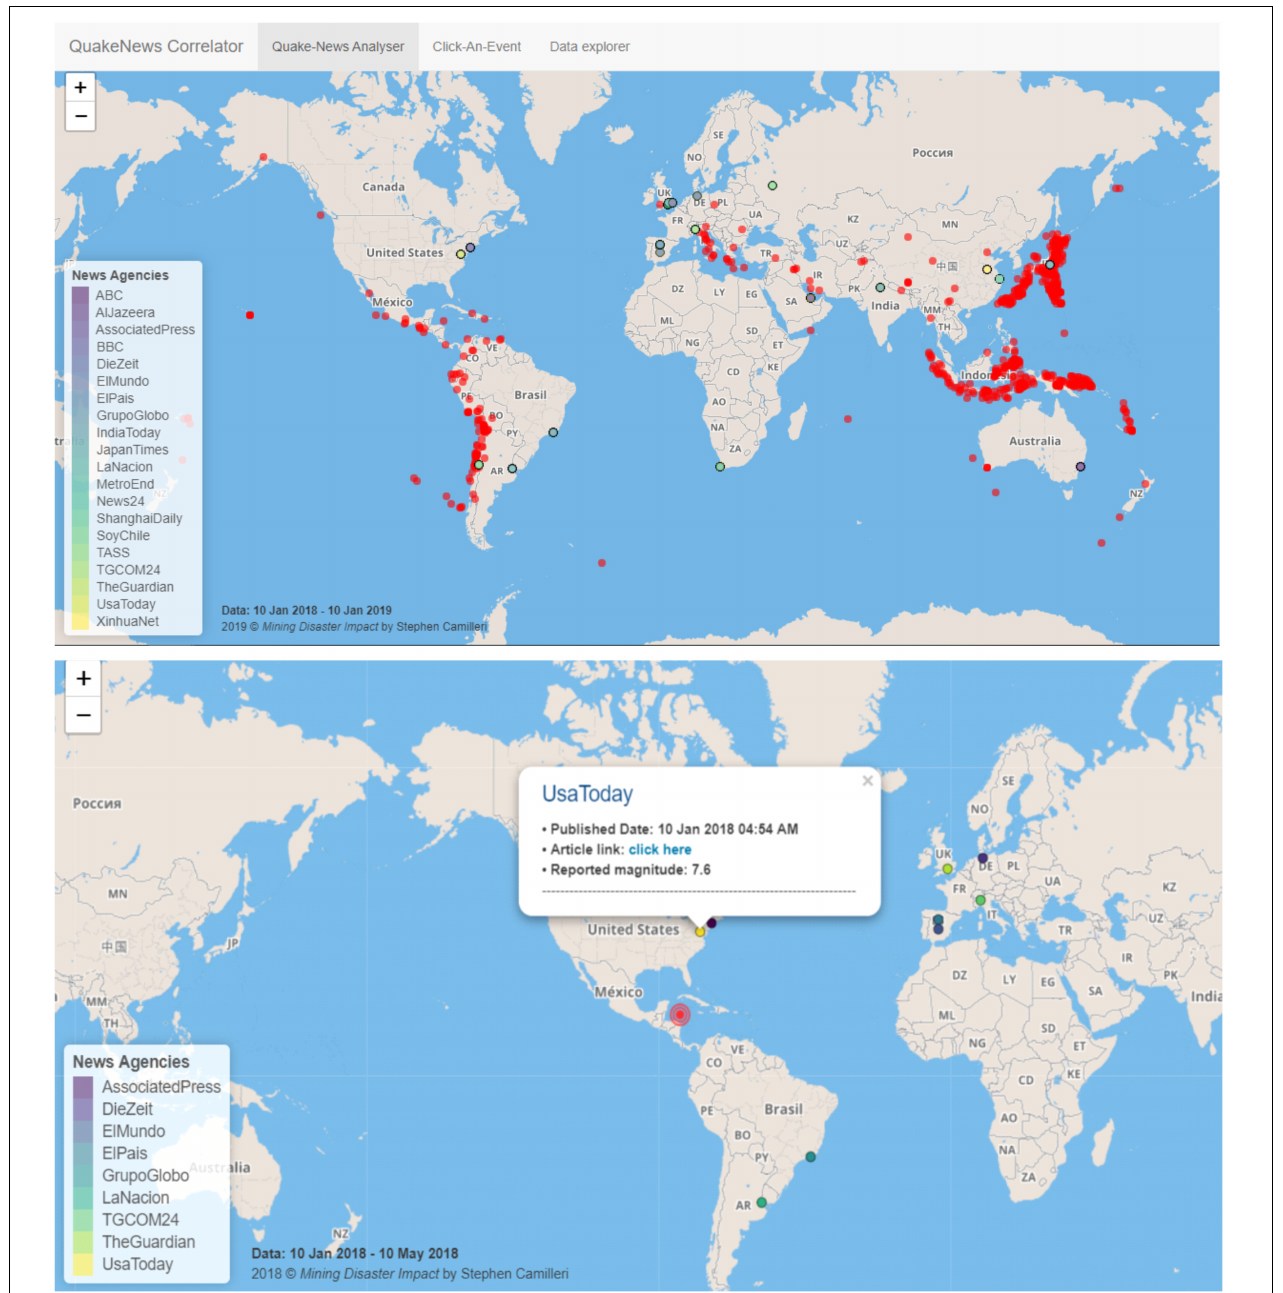
FIGURE 2 | Graphic user interface of QuakeNews Analyser. Top map shows the location of 698 earthquake epicenters (red dots), and the location of news agencies’ headquarters who reported about these events (color shaded dots). Bottom map shows an example of the news coverage for a magnitude 7.6 earthquake that occurred on Great Swan Island off the coast of Honduras on the 9th of January 2018 (red marker) (see also Figure 3 ). Colored dots show the agencies which reported the event. Tab shows details of a published article by USA